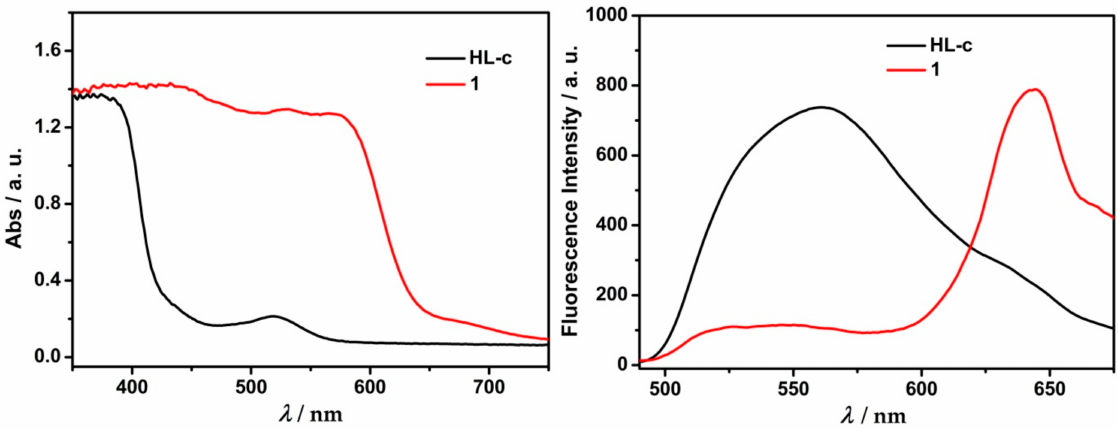
Figure 2. The solid-state UV-vis spectra ( left ) and the solid-state fluorescence spectra ( right , λ ex = 365 nm) for HL-c and Complex 1